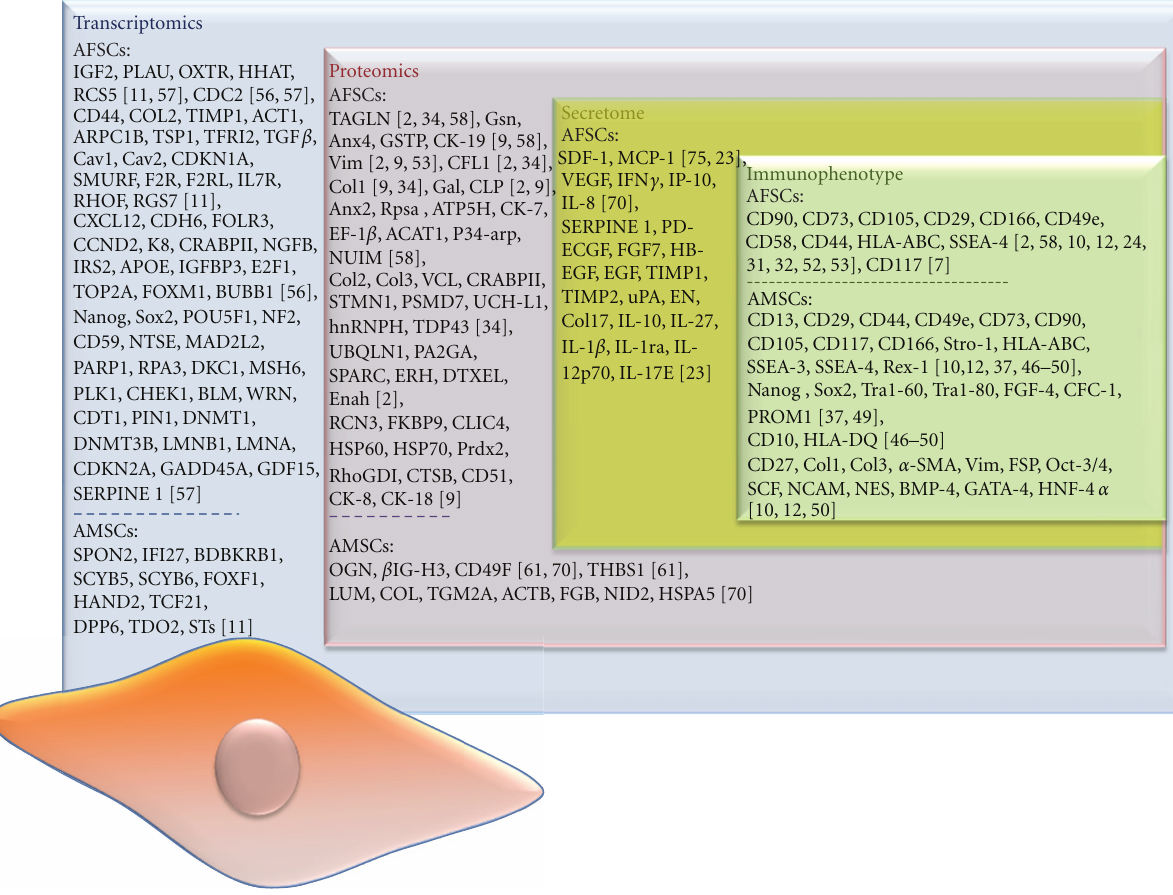
Figure 1: Summary of the most important markers identified in AFCs and AMCs by the use of transcriptomics, proteomics, secretome, and immunophenotypic analyses. Proteins identified in more than one study are marked in